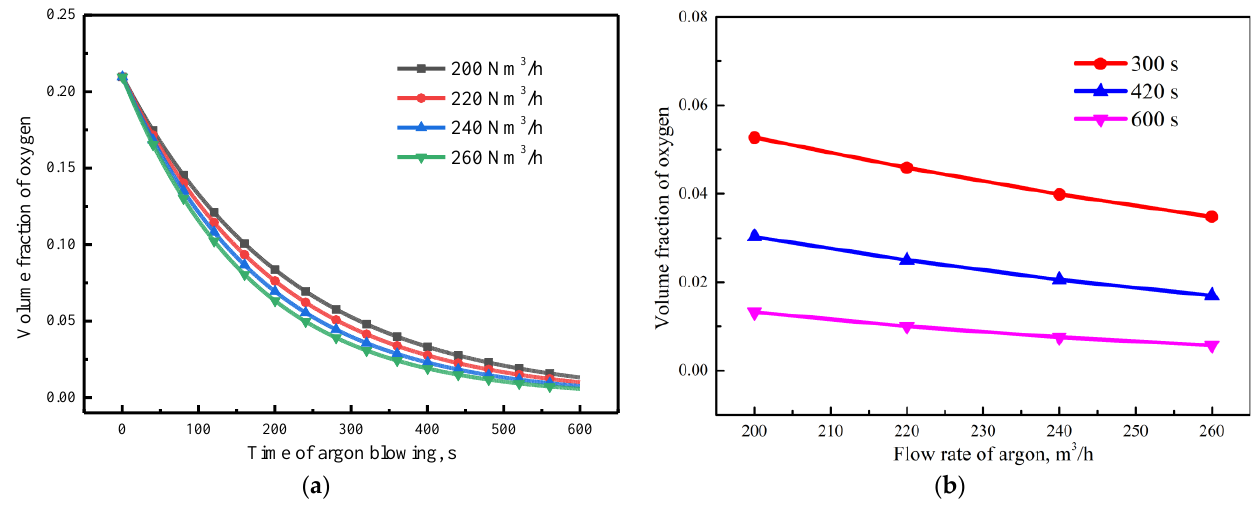
Figure 7. Variation of volume fraction of oxygen with time for different argon flow rates ( a ), and effect of argon flow rate on the volume fraction of oxygen at different times ( b ).